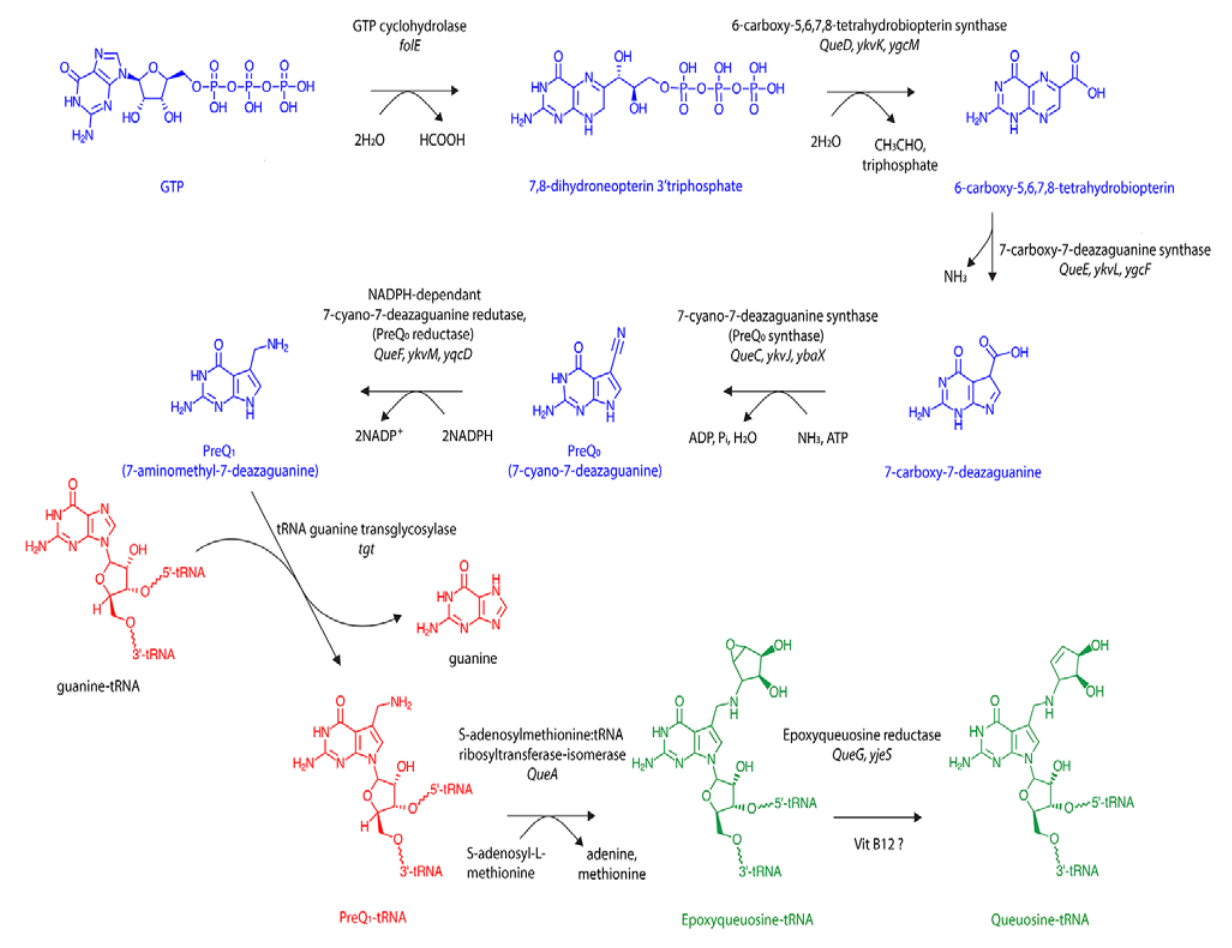
Figure 2. De novo biosynthesis of queuosine by eubacteria. Queuosine biosynthesis occurs exclusively in eubacteria via initial hydrolysis of the ribose of a guanosine triphosphate nucleoside (GTP) precursor and breakage of the imidazole ring by GTP cyclohydrolase to yield 7,8-dihydroneopterin-3′-triphosphate. In the next two steps triphosphate and acetaldehyde are removed from the pteridine molecule followed by disruption of the pyrazine ring and loss of an amino group to yield 7-carboxy-7-deazaguanine. The fourth and fifth steps in the synthesis are ATP-dependent and NADPH-dependent, respectively, with an aminomethyl group replacing the carboxyl group at position 7 of the 7-deazaguanine molecule to yield the precursor base 7-aminomethyl-7-deazaguanine (PreQ 1 ). Eubacterial tRNA guanine transglycosylase then removes guanine from the C1-ribose at the wobble position of the anticodon without cleaving the sugar backbone before inserting PreQ 1 in a base-for-base exchange reaction. The final two modification steps occur within the context of the tRNA molecule. Firstly, S-adenosylmethionine: tRNA ribosyltransferase-isomerase transfers the ribose moiety from S-adenosylmethionine to the 7-aminomethyl group of PreQ 1 -tRNA. Finally, the oxygen at the C1″ and C2″ of the cyclopentene ring of poxyqueuosine-tRNA is removed in a vitamin B12-dependant reaction to yield queuosine-modified tRNA. Enzyme names are shown in black and below current gene names together with the classical nomenclature from Z. mobilis and E. coli